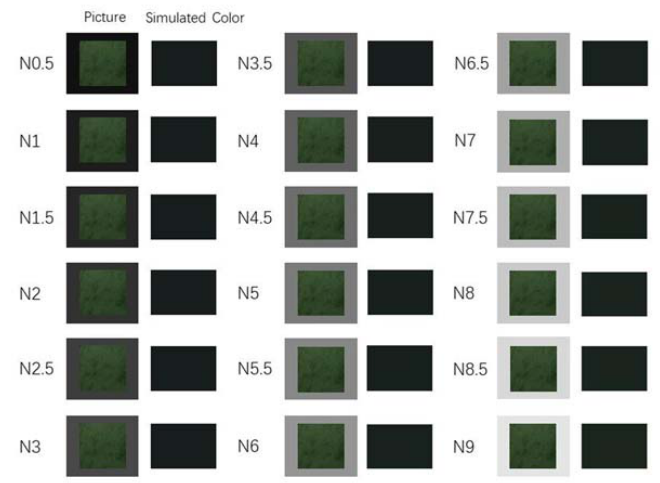
Figure 5. Pictures of a serpentine jade sample on 18 Munsell neutral backgrounds, shown with the associated colors.